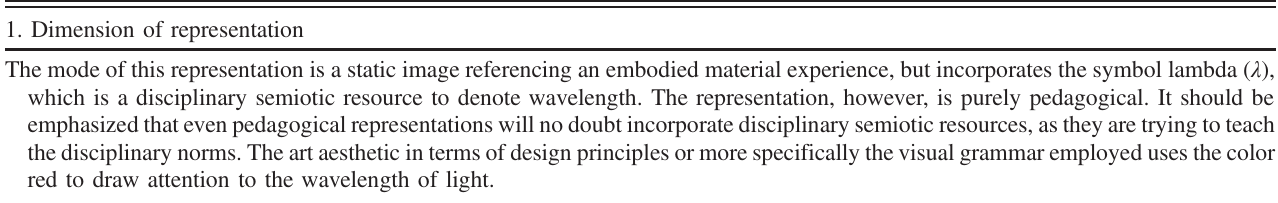
TABLE V. Unpacking the representation of the rubber band analogy for cosmological expansion.